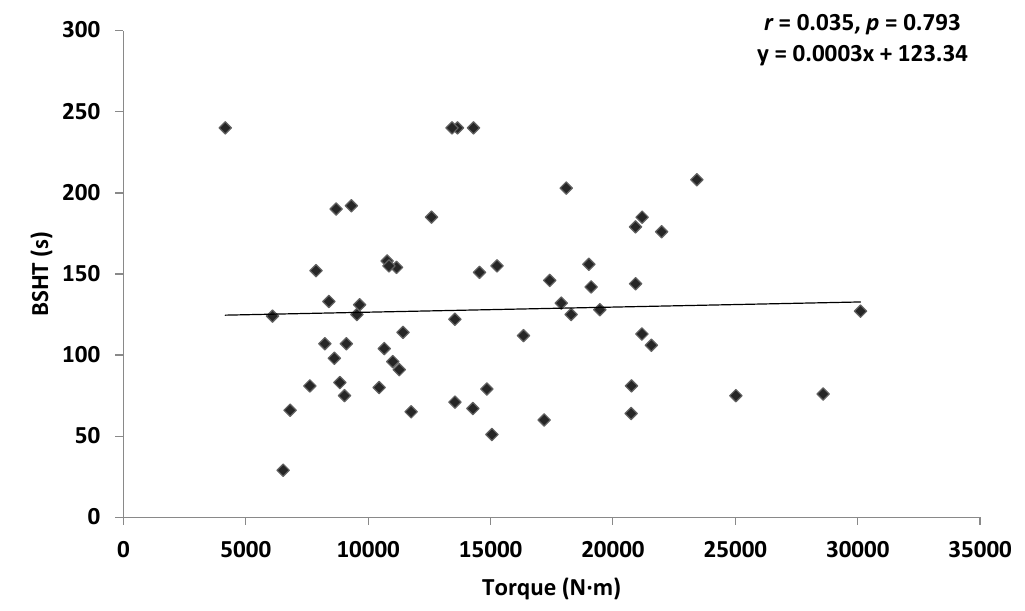
Figure 3. Scatter plot of combined group data for isolated lumbar extension (ILEX) strength index (SI) and trunk extension (TEX) endurance (Biering-Sorensen hold time (BSHT)).